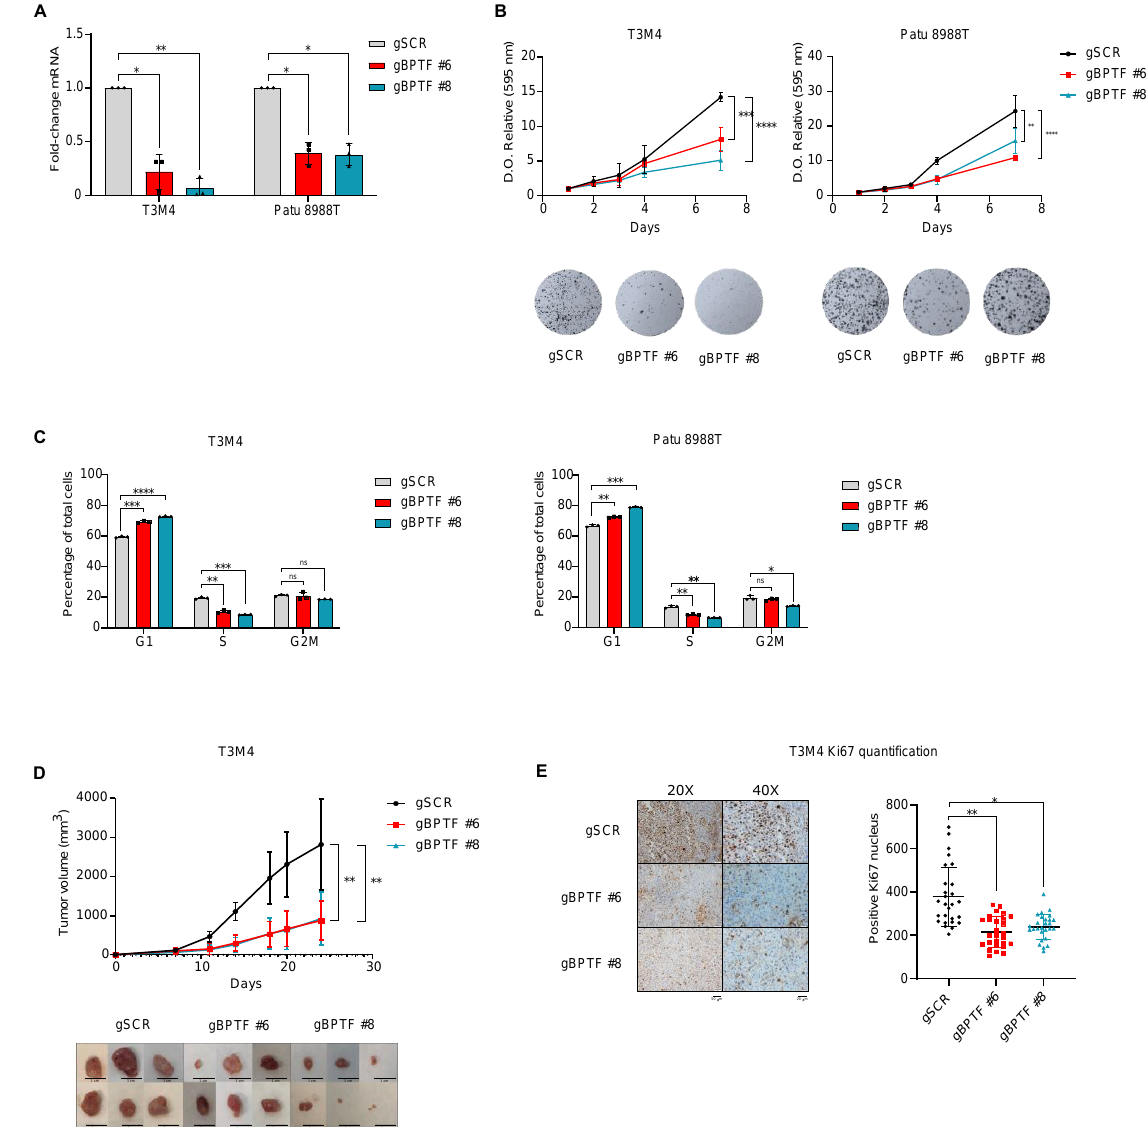
best gRNAs (Figure 2A and Supplementary Figure S1D). We downregulated BPTF lev- els by CRISPRi in the aforementioned four human PDA cell lines—Patu 8988T, Patu 8988S, Panc1, and T3M4—and analyzed cell proliferation and colony growth (Figure 2A,B and Supplementary Figure S2A–C). These results were further validated using a specific shRNA (Supplementary Figure S3). As we expected, BPTF downregulation decreased cell proliferation in all the cell lines tested. This reduction was consistent with the accumulation of cells in the G1 phase of the cell cycle (Figure S2C). To confirm those results in vivo, we subcutaneously implanted in nude mice T3M4 and Patu 8988T silenced for BPTF or CRISPRi non-target controls. Consistent with our results using KPC-derived cells, we observed a dramatic reduction in tumour growth after BPTF-silencing in both human cell lines, along with reduced staining for the proliferative marker Ki67 (Figure 2D,E and Supplementary Figure S2D). With these results, we can conclude that BPTF is required for cell proliferation and tumour growth in human PDA.